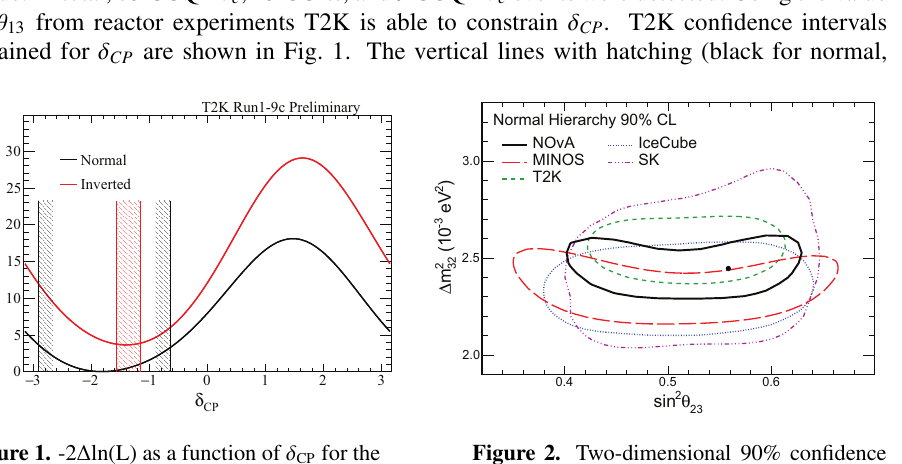
Figure 1. -2 ∆ ln(L) as a function of δ CP for the normal (black) and inverted (red) mass hierar- chy using reactor constraint on θ 13 . The ver- tical lines show the corresponding allowed 2 σ confidence intervals.